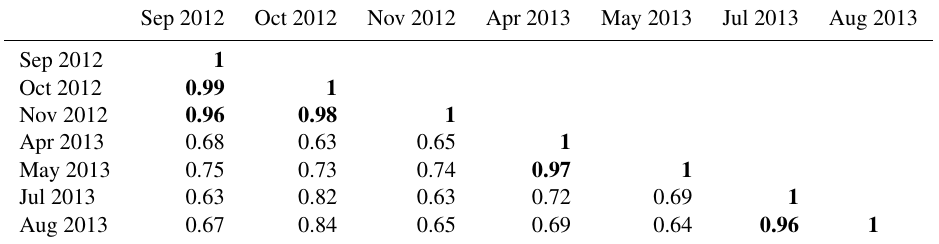
Table 5. Spearman rank correlation coefficients ( r s ) between spatial patterns of soil moisture ( θ d,50 ) in the deep soil horizon. Values of r s ≥ 0.9 are highlighted in